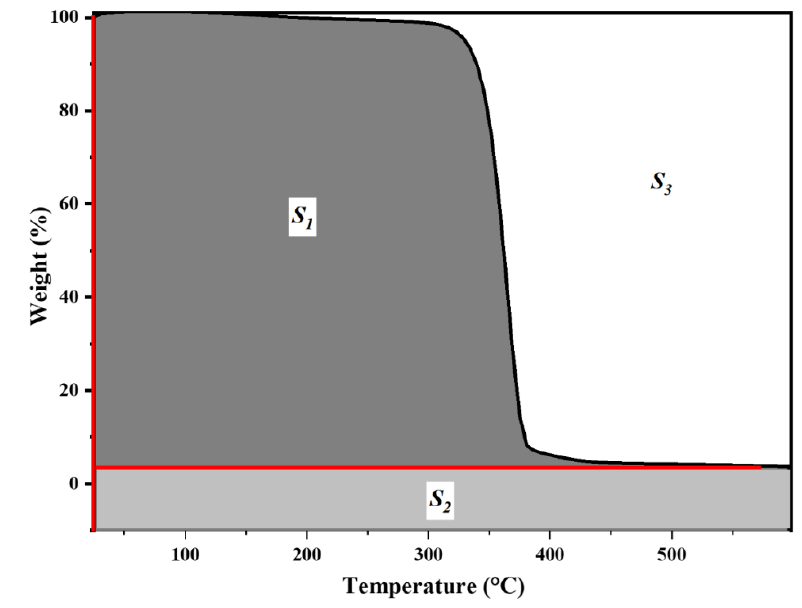
Figure 2. Schematic representation of S 1 , S 2 , and S 3 areas for calculation of A* and K* .